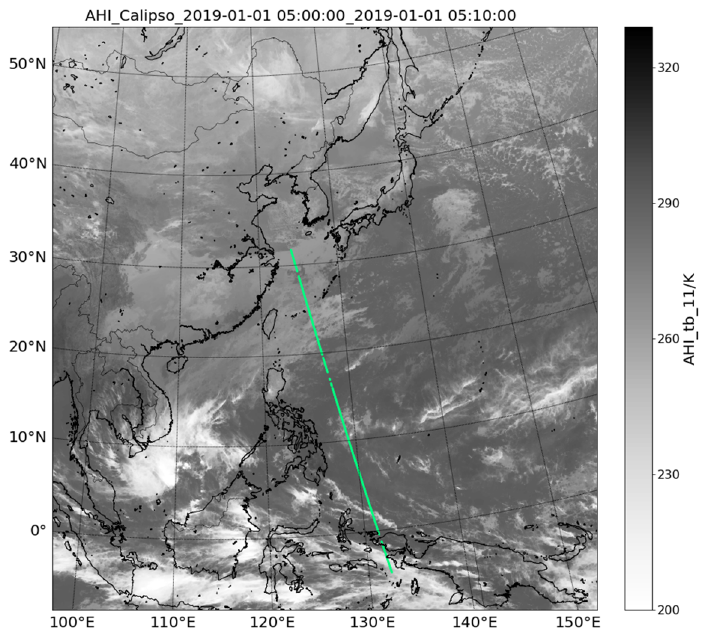
Figure 1. AHI and CALIOP data